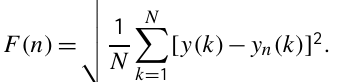
Figure 2. Excerpts of the analyzed time series displaying dichotomous features: a) SES activity in